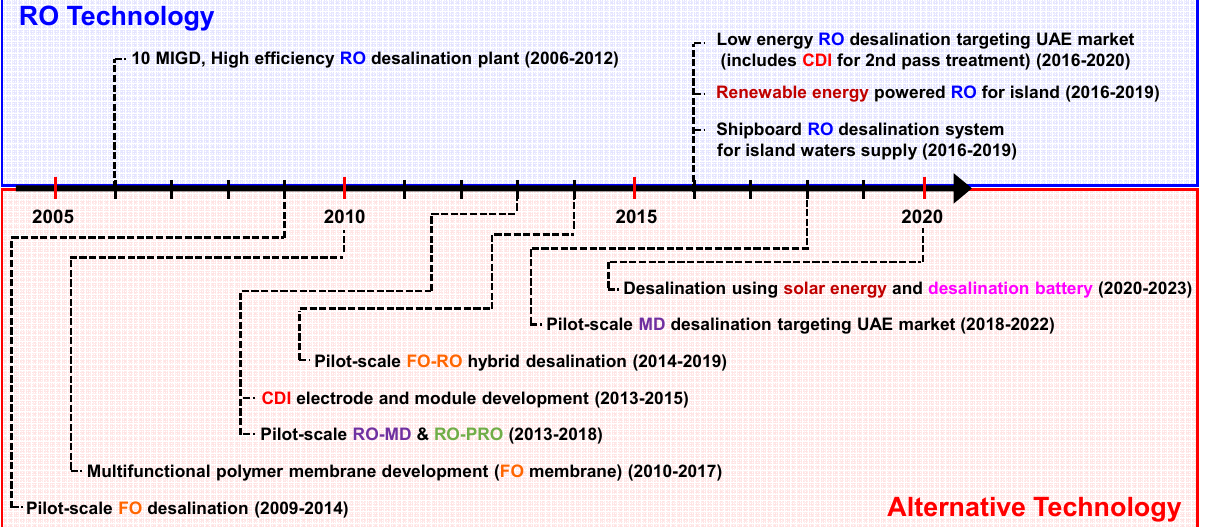
Figure 3. The milestones of major desalination research in South Korea.